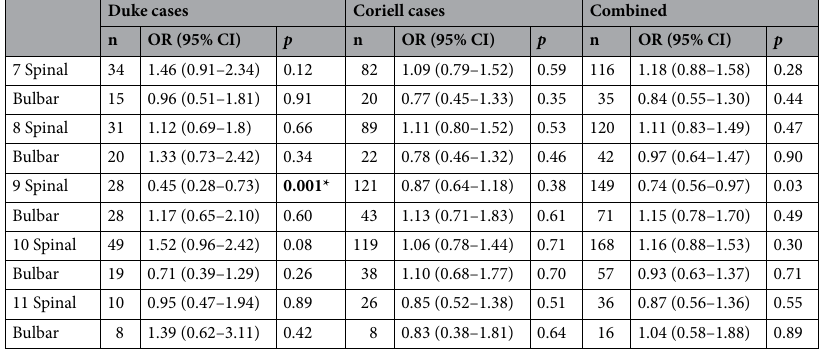
Table 2. Corrected regression models evaluating the association between NEFH TTTA alleles and disease risk in two sporadic ALS cohorts stratified by site of disease onset. Data taken from binary logistic regression models with correction for patient sex. P and OR (95% CI) values are calculated for the comparison to all other alleles. OR, odds ratio; CI, confidence interval, p , statistical significance. Values in bold with * denote statistical significance after Bonferroni correction p < 0.005.